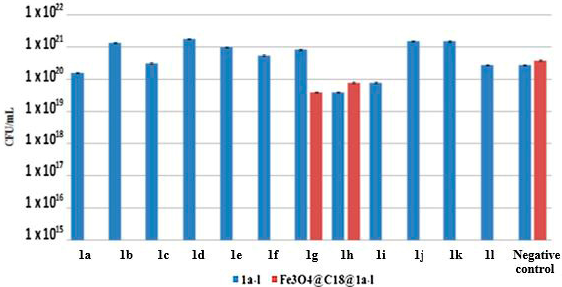
Figure 1. Viable cell counts of fungal cells harvested from 24 h biofilms developed on glass slides covered with bare compounds (C) (blue) or hybrid nanosystems (thiourea derivatives loaded at the same concentration in nanoparticles) (red).